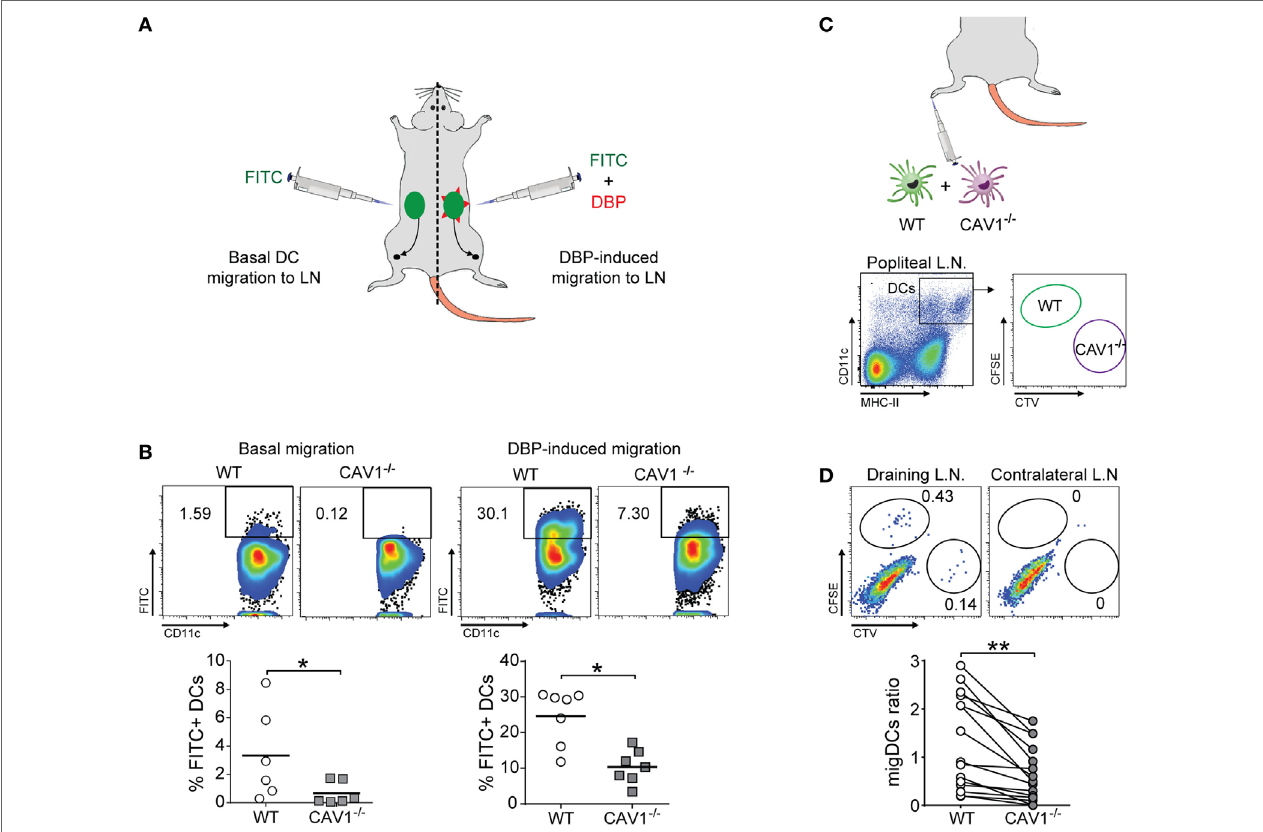
FigUre 2 | Caveolin-1 (CAV1) favors dendritic cell (DC) trafficking to lymph nodes (LNs) in vivo (a,B) . Back skin of wild-type (WT) and CAV1 − / − mice were treated with FITC (left flank) or FITC + dibutyl phthalate (DBP) (right flank), as summarized in (a) . (B) After 24 h, the arrival of skin-derived FITC + DCs to inguinal LNs was evaluated. Representative density plots (top panels) and quantification of FITC + DCs (bottom panels) under basal or DBP-induced conditions are shown. Each dot represents one animal, and the bar is the mean (* p < 0.05, n = 7). (c,D) WT and CAV1 − / − bone marrow-derived DCs (BM-DCs) were stained with CFSE and Cell Trace Violet (CTV), respectively. Then, WT recipient mice were subcutaneously injected in the right footpad with 5 × 10 5 cells (1:1 ratio, WT to CAV1 − / − ) or with PBS as a control (left footpad). The arrival of CFSE (WT) or CTV (CAV1 − / − ) BM-DCs to the draining (right) and contralateral (left) popliteal LNs was evaluated 24 h later. (c) Scheme of footpad injection and gating analysis to analyze transferred BM-DCs. (D) Representative dot plots of DCs in the draining popliteal LNs are shown. Gates showing injected WT and CAV1 − / − DCs are displayed. The migration index of WT or CAV1 − / − DCs was calculated as {[% CTV stained DC in popliteal lymph nodes (PLN)]/(% CTV stained DC in input)}/[(% CFSE WT DC in PLN)/(% CFSE WT DC in input)]. Data are presented as dot plots with connecting lines per paired samples. ** p < 0.01, n = 16 mice, from three independent